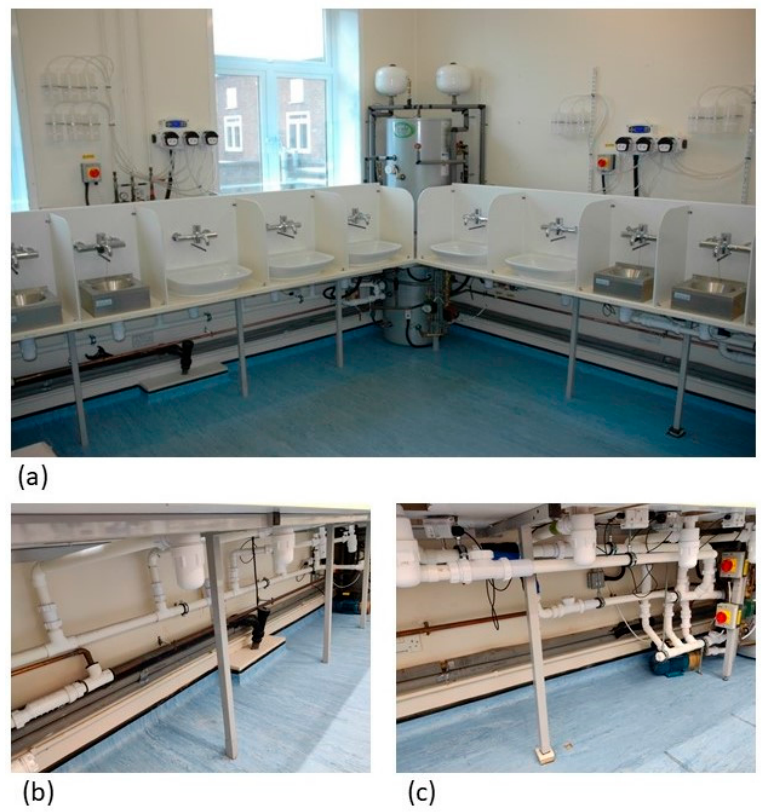
Figure 1. Sinks commonly found in healthcare settings installed as part of a laboratory model system ( a ). Sinks drain into a common wastewater pipe ( b ) or individual wastewater pipes ( c ).